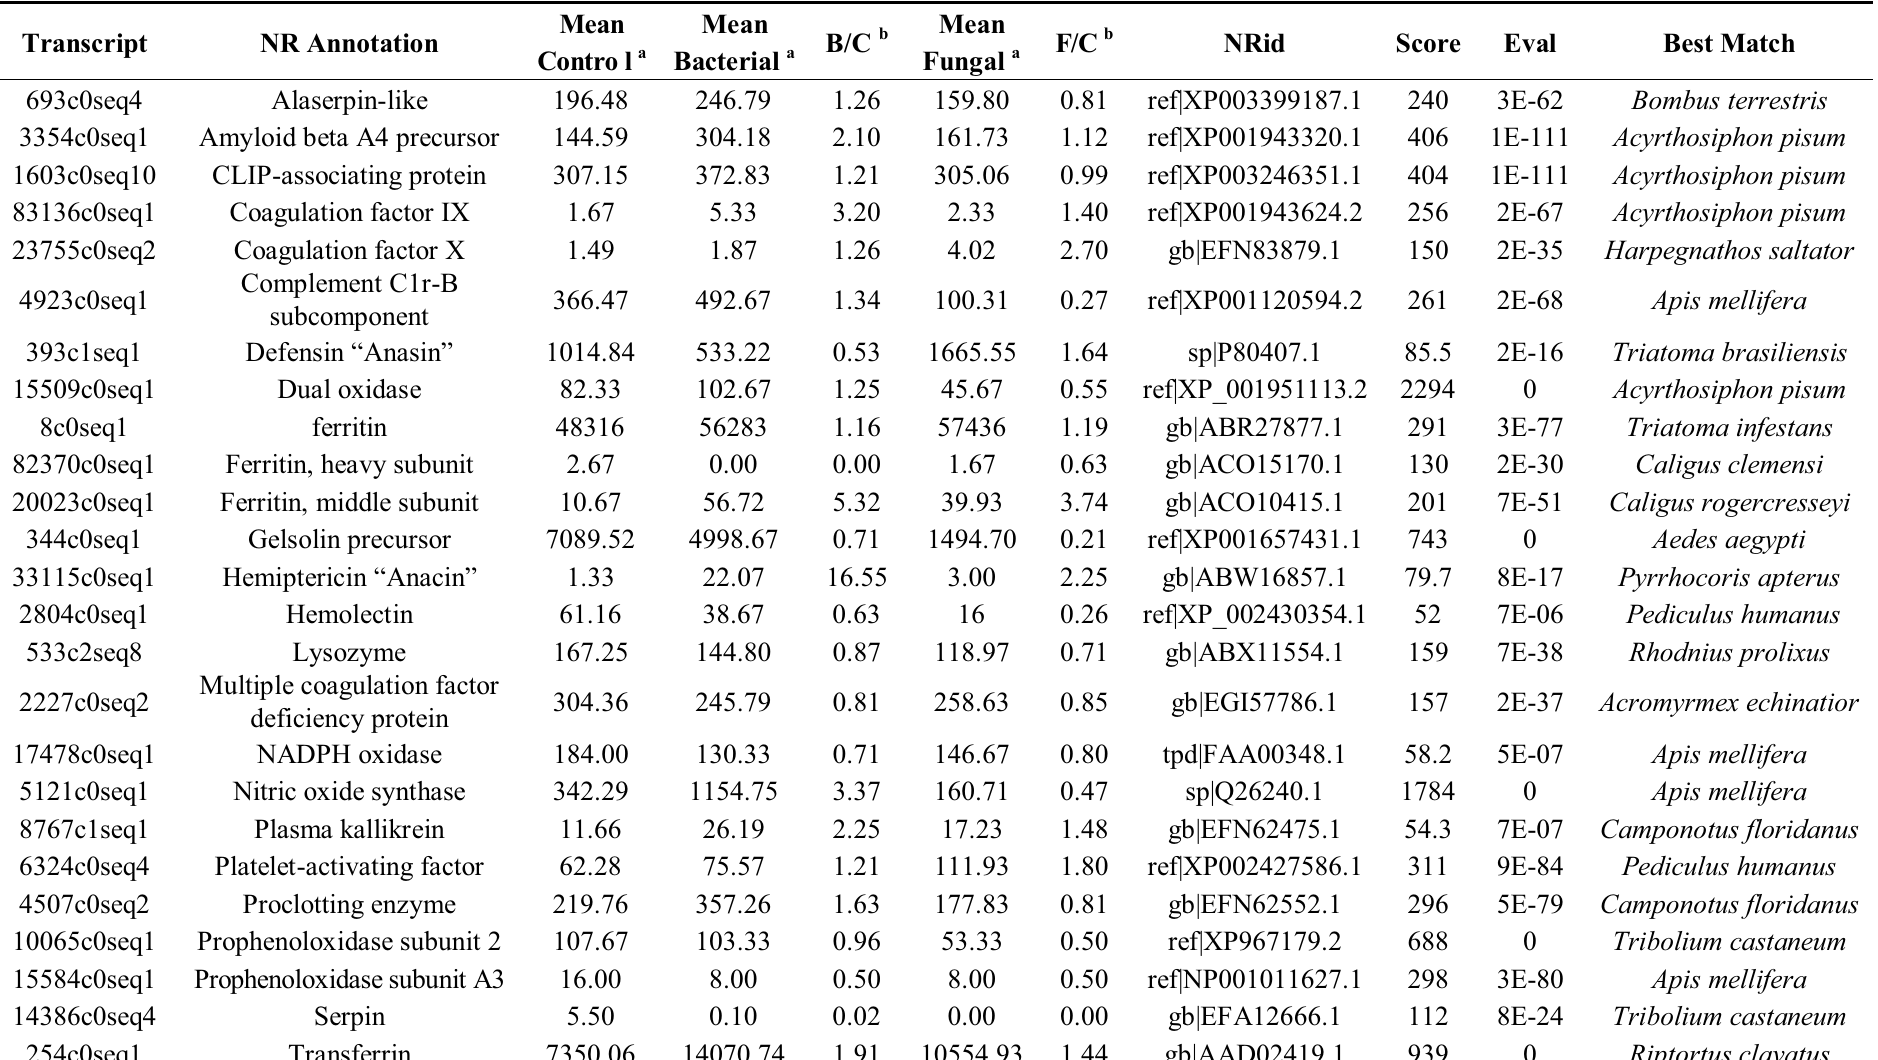
Table 3. Expression profiling of Anasa tristis antimicrobial and melanization unigenes in response to bacterial or fungal elicitation 18 h post